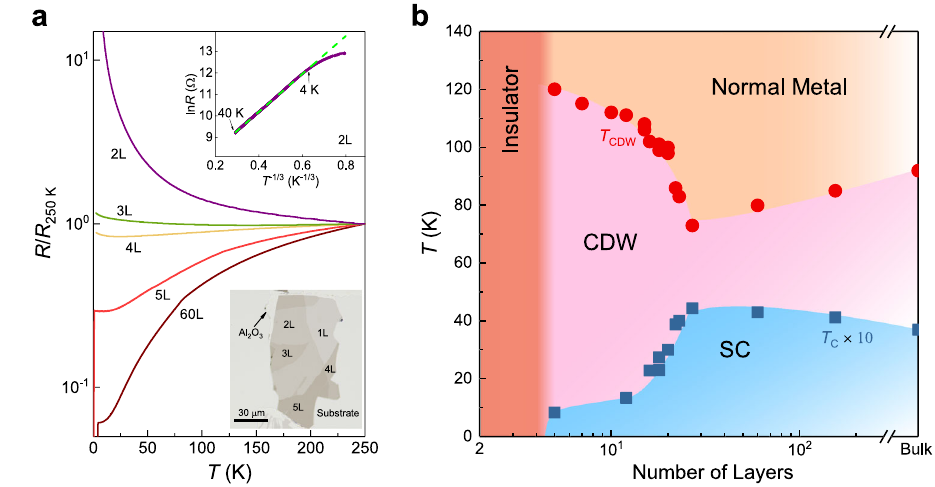
Fig. 4 | Thickness-dependent resistance and phase diagram of CsV 3 Sb 5 approaching the 2D limit. a Temperature-dependent resistance of CsV 3 Sb 5 with different fl ake thicknesses from 2 – 5 layers. A sample with 60L is included for comparison. Monolayer CsV 3 Sb 5 turns out to be an insulator and its resistance